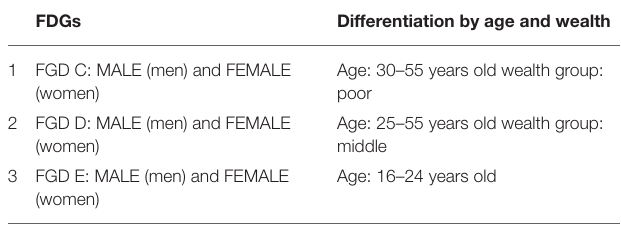
TABLE 1 | Overview of details of the three different FGDs (Petesch et al., 2018b). FDGs Differentiation by age and